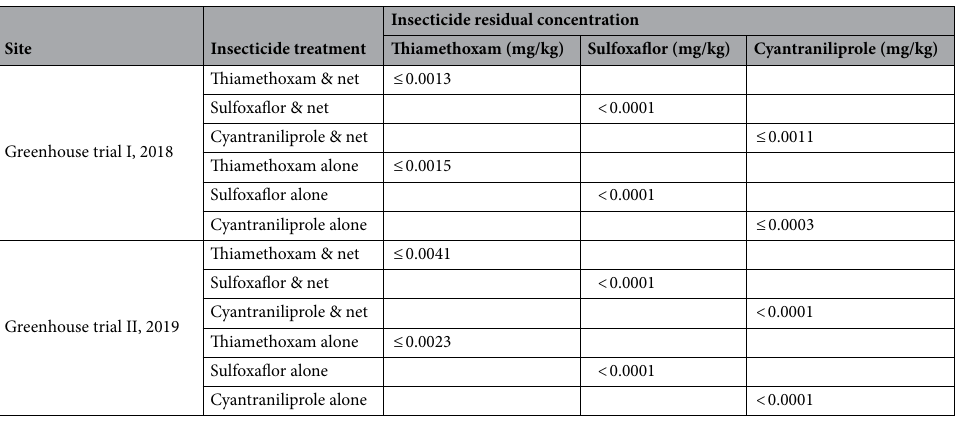
Table 5. Insecticide residues in tomato fruits in different insecticide treatment plots at the time of first harvest in two greenhouse